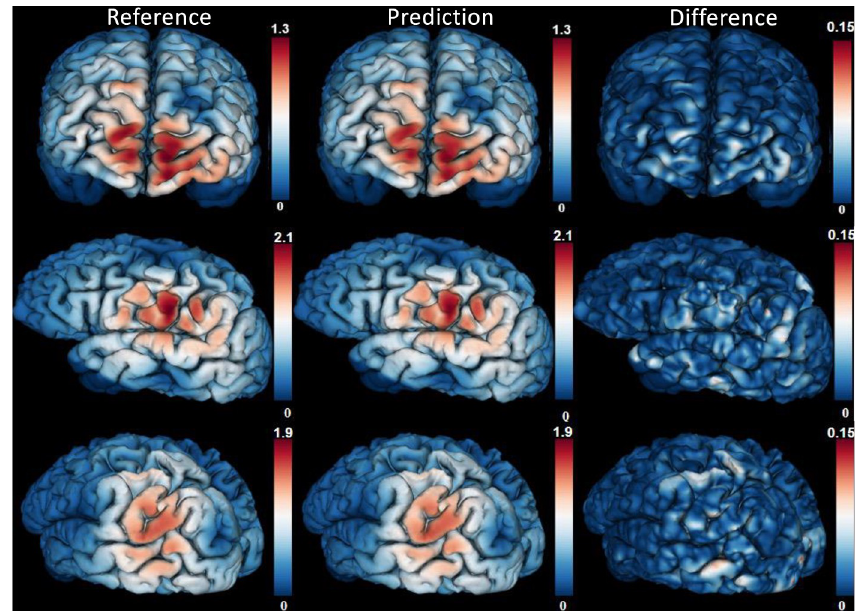
Fig 3. The magnitude [V/m] of E-field from VCM (the first column) and C-60 (the middle column), and the absolute difference between VCM and C-60 (the last column) with the Magstim-70mm-Fig8 placed at three positions of one testing